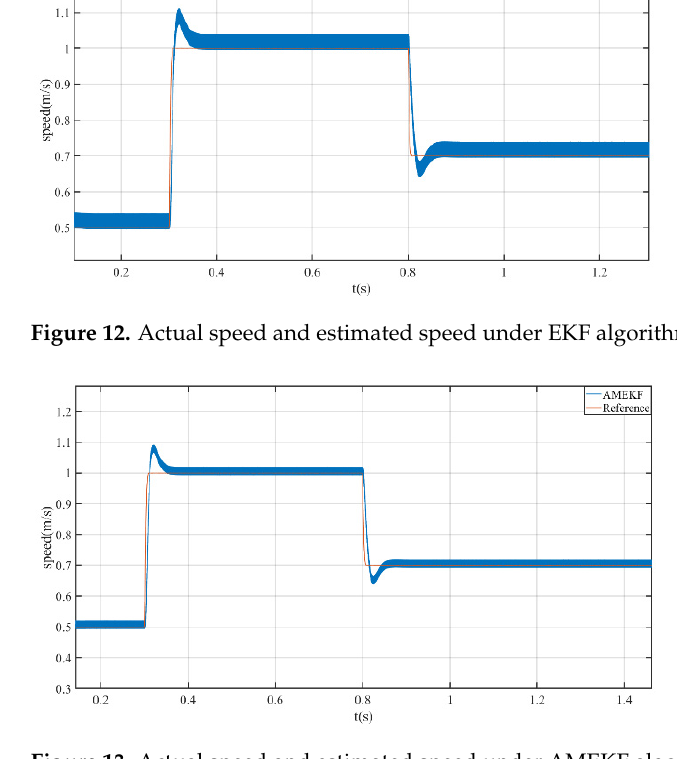
Figure 13. Actual speed and estimated speed under AMEKF algorithm .